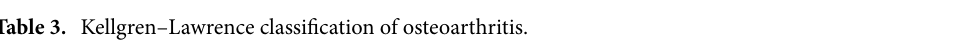
Table 3. Kellgren–Lawrence classification of osteoarthritis.